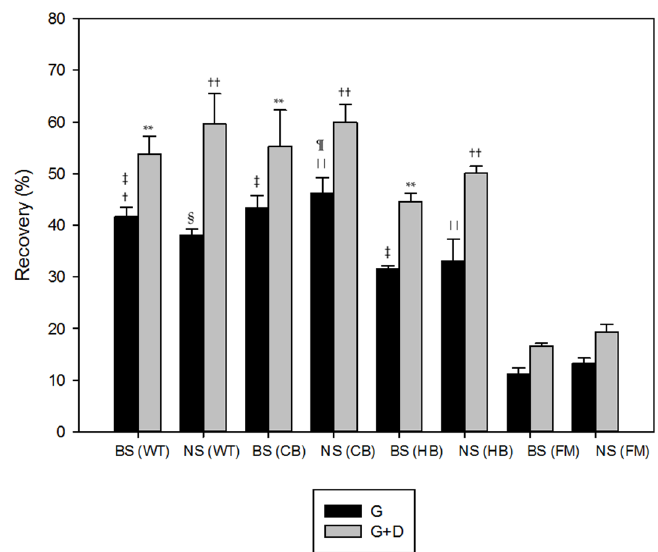
Figure 2. Recovery of total phenolic compounds in the digestion medium from natural almond skin (NS) and blanched almond skin (BS) in water (WT), home-made biscuits (HB), crisp-bread (CB) and full-fat milk (FM). Values are given as % of total phenolic compounds calculated from the amount of polyphenols present in the medium at the end of each step of digestion. Values represent averages ( ± SD) of triplicate measurements. † p < 0.01 vs. BS (CB); ‡ p < 0.01 vs. BS (FM); § p < 0.01 vs. NS (CB); || p < 0.01 vs. NS (FM); ¶ p < 0.01 vs. NS (HB); ** p < 0.01 vs. BS (FM); †† p < 0.01 vs. NS